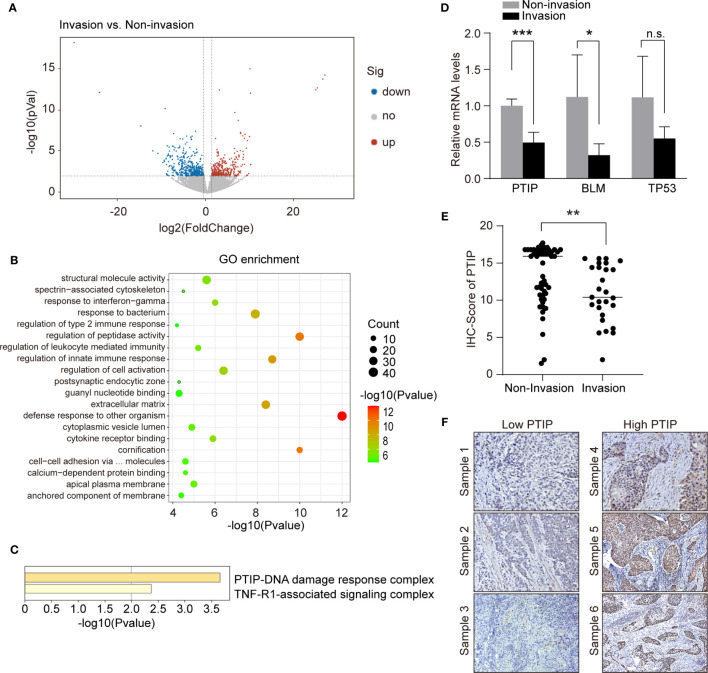
PTIP expression negatively correlates with lymph node metastasis in ESCC. (A) Volcano plot showing differentially expressed genes between tumor biopsies with and without lymph node metastasis using RNA-seq. Volcano plot shows the log2 fold change (x-axis) and significance (−log10*adjusted P-value; y-axis) with significantly downregulated and upregulated genes shown in blue and red, respectively (adjust P < 0.01 and |log2Foldchange| > 0.9). (B) GO enrichment of differentially expressed genes from (A). (C) Functional enrichment analysis of differentially expressed genes from (B) using CORUM gene set. (D) quantitative RT-PCR analysis of genes that downregulated in lymph node metastasis positive ESCC samples. Unpaired, two-tailed Student’s t-test; *P < 0.05; ***P < 0.001; n.s., not significant. (E) IHC score for PTIP in ESCC tumor sections. Unpaired, two-tailed Student’s t-test; **P < 0.01. (F) Representative IHC images for PTIP in ESCC tumor sections. Low PTIP and high PTIP groups were divided based on the PTIP immunostaining intensity scores mentioned in method. Cut off for high and low PTIP expression in ESCC was defined < or > 11. Percentage of invasion and non-invasion in ESCC groups is depicted in
Table 4
.